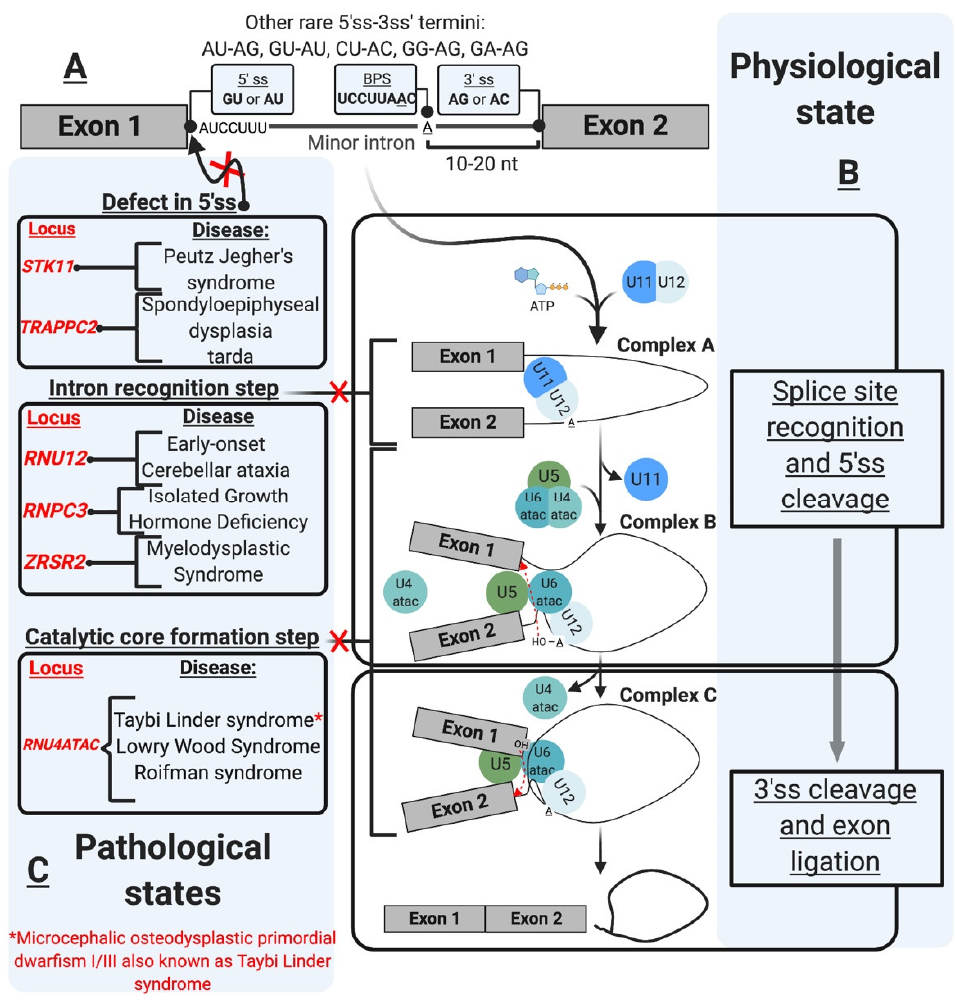
Figure 1. The minor intron splicing pathway. ( A ). U12-type intron sequence characteristics [1–6]. These sequences were initially described in the literature based on DNA nomenclature. These were changed in the figure as the transcript depicted is an RNA transcript. The commonly observed 3′ and 5′ sequences of minor introns are shown in the boxes. The conserved sequences are shown at the 5′ ss and branchpoint ( B ). Spliceosomal assembly and the splicing reaction [7–12] occur as a two-step reaction. The interaction of the preformed U11/U12 di-snRNP leads to the formation of Complex A. U4atac/U6atac.U5 tri-snRNP allows the formation of Complex B, which carries the first transesterification reaction after the release of U4atac and U11. This reaction leads to the formation of Complex C, which carries the second transesterification reaction producing ligates exons and a minor intron lariat. ( C ). U12-type intron-associated diseases classification [13–21]. The diseases are depicted in association with the affected step. Diseases not shown in the figure include amyotrophic lateral sclerosis associated with mutations in fused in sarcoma (FUS) RNA-binding protein [22], and Noonan syndrome due to U12-type intron retention in LZTR1, a regulator of RAS-related GTPases [23].